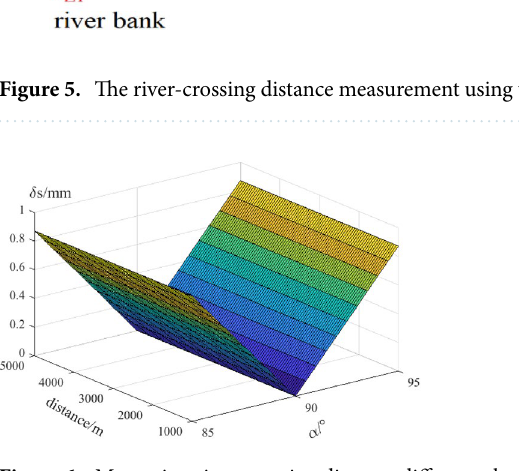
Figure 6. Measuring river-crossing distance difference between GNSS and total